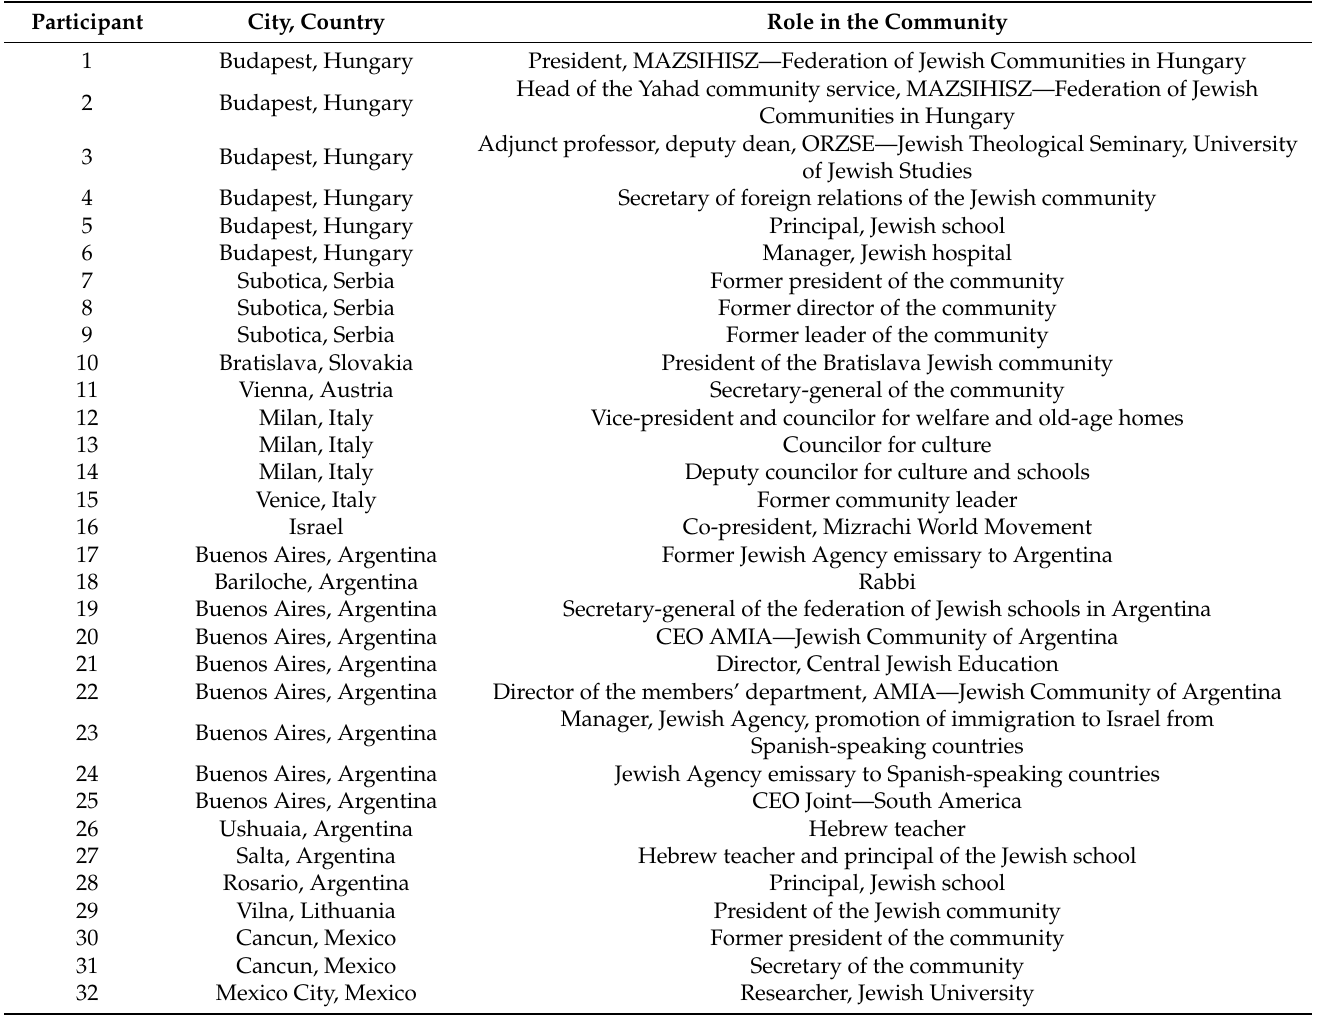
Table 1. List of the